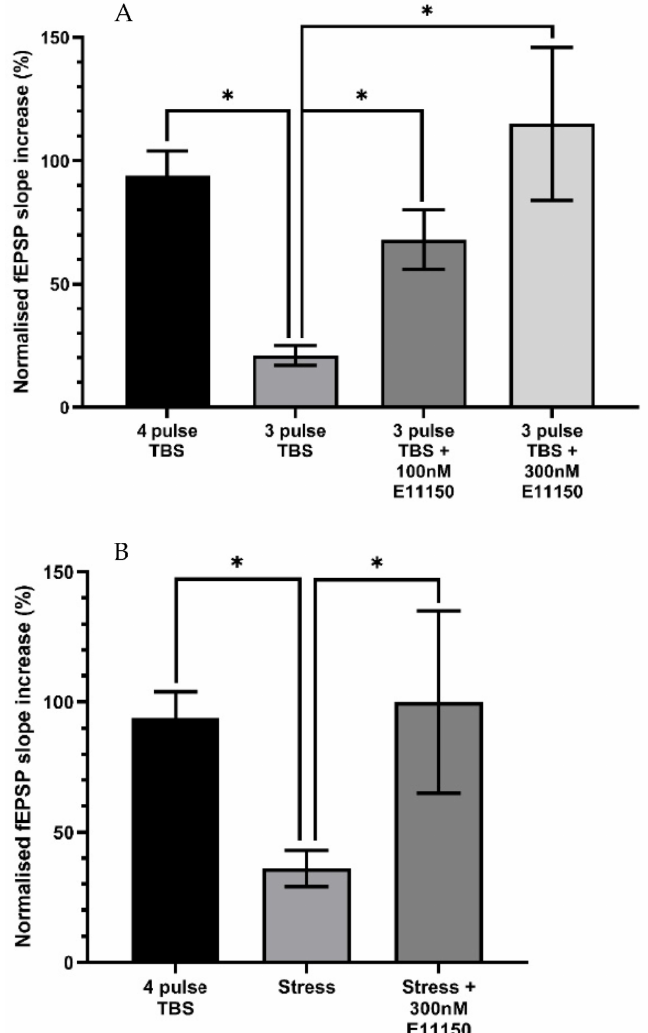
Figure 8. Application of E11150 to mouse hippocampal slices enhances submaximal and stress impaired LTP recorded from CA1 pyramidal neurones. Panel ( A ) The histogram illustrates that the magnitude of LTP (expressed as the percentage increase of the fEPSP slope) induced by the delivery of a 3-pulse TBS is significantly less than that resulting from delivery of a 4-pulse TBS protocol. The bath application of E11150 (100 nM and 300 nM) significantly enhanced the magnitude of LTP induced by the 3-pulse TBS. Each column represents the mean ± SEM of 4–11 individual experiments (* p < 0.05). Panel ( B ) A prior episode of acute stress to mice decreased the magnitude of ex vivo CA1 pyramidal neuron LTP induced by a 4-pulse TBS, in comparison to that induced by a 4-pulse TBS, recorded from equivalent CA1 neurones obtained from control mice. The bath application of E11150 (300 nM) significantly enhanced the magnitude of stress impaired LTP. Each column represents the mean ± SEM of 4–12 individual experiments * p <